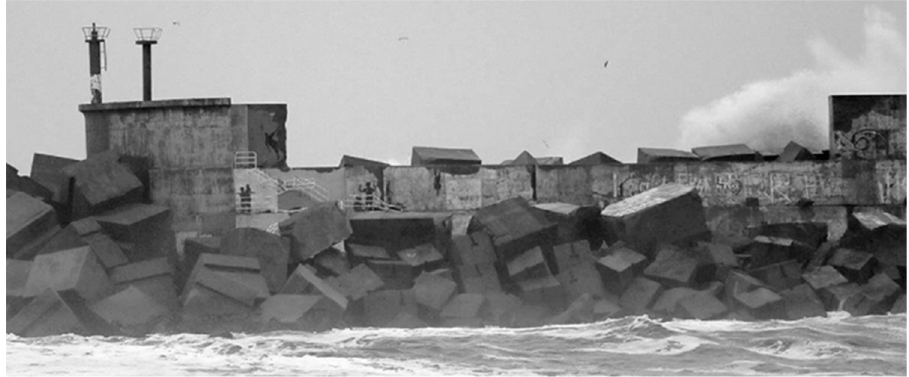
Figure 18. Displacement of the upper part of the crown wall in the breakwater of A Garda, Spain (2017).